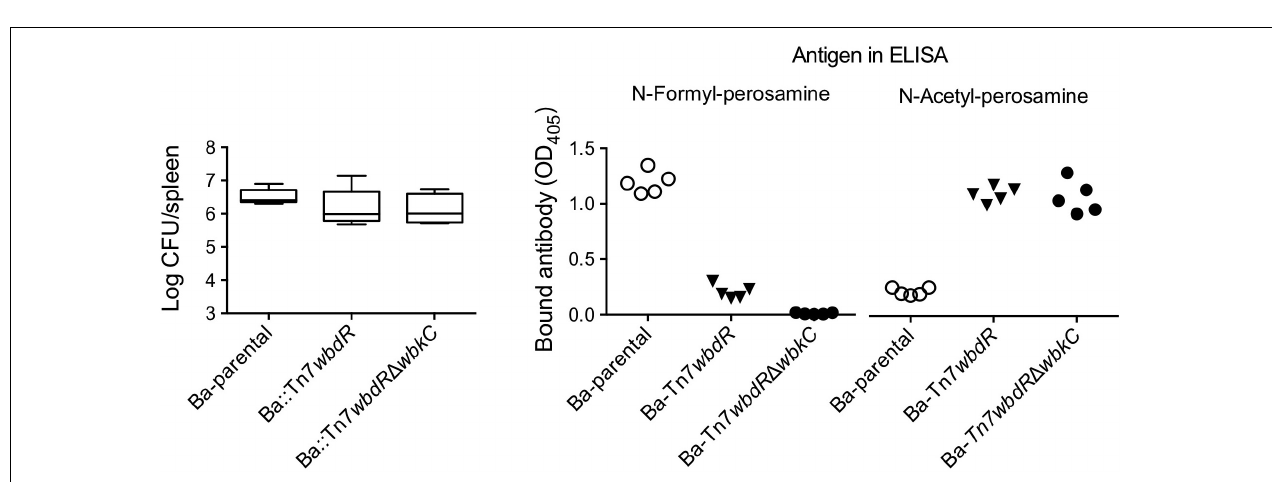
FIGURE 7 | Brucella abortus wbdR constructs produce chronic infections in mice that trigger antibodies to the new epitopes. (Left) Bacterial loads in the spleens of BALB/c mice at 8 weeks post-infection. (Center and Right) Reactivity of sera from mice infected with Ba-parental, Ba::Tn7 wbdR or Ba::Tn7 wbdR (cid:49) wbk C in ELISA performed with the S-LPS of Ba-parental ( N -Formyl-perosamine iELISA) or Ba::Tn7 wbdR (cid:49) wbk C (N-Acetyl-perosamine iELISA). The ODs correspond to the serum dilution (1:50) showing the maximal discrimination between the wild-type and the wbdR constructs.